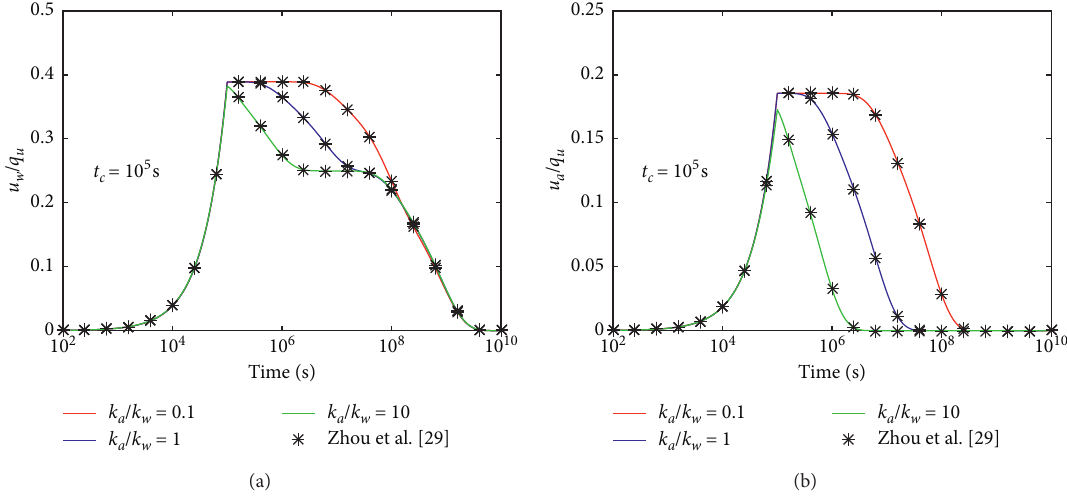
Figure 5: Comparison between the degenerate solution and the existing solution for ramp loading.